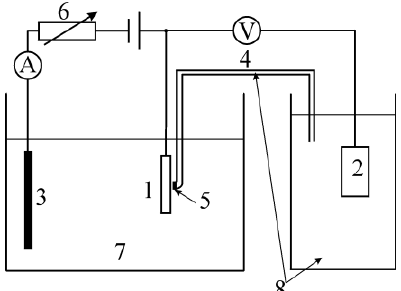
Figure 2. Three electrode system: 1 — test sample (working electrode), 2 — SCE (reference electrode), 3 — Pt auxiliary electrode, 4 — salt bridge, 5 — semipermeable membrane, 6 — adjustable voltage source, 7 — electrolyte, 8 — solution of own ions of reference electrode.